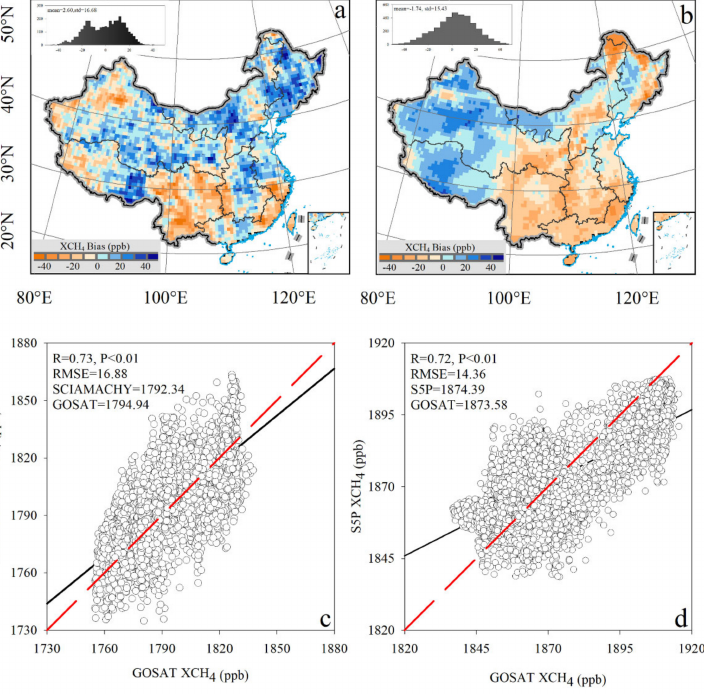
Figure 2. Comparison of XCH 4 concentrations from different satellites. ( a ) The XCH 4 bias calculated by subtracting GOSAT data from SCIAMACHY data during the overlap time (January 2010 to